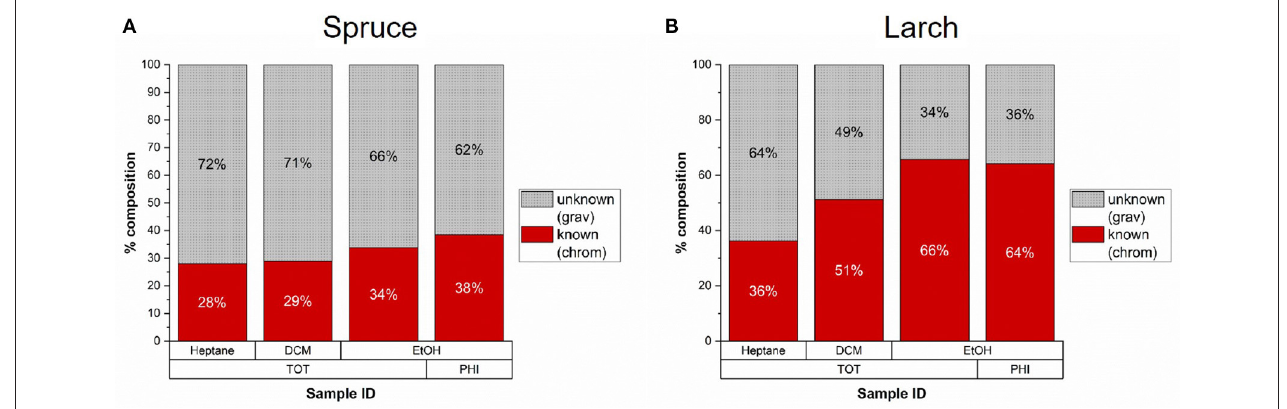
FIGURE 5 | Average percentage of extractives from milled samples with known composition as determined by gas chromatography compared to the total gravimetric yield ( n = 2). (A) In Norway spruce 28–38% of the gravimetric yields were detected by chromatography. (B) In Larch 36–66% of the extracts were detected by chromatography.